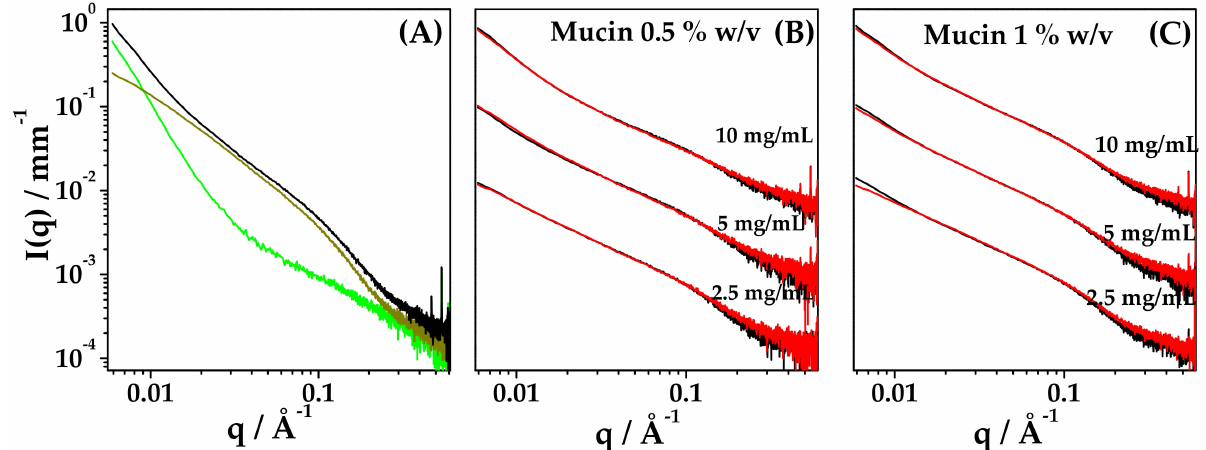
Figure 10. Stability of nanoparticles in mucus model. SAXS intensity profiles. ( A ) 10 mg/mL HYA–DEX nanodispersion (green), 1% w/v mucin (dark yellow) and admixed 10 mg/mL HYA–DEX nanoparticles dispersed in 1% w/v mucin (dark yellow). ( B , C ) Experimental profiles (black) and reconstructed profiles (red) of HYA–DEX nanoparticles dispersed in mucin; mucin concentration ( B ) 0.5% w/v and ( C ) 1% w/v . HYA–DEX concentration: 2.5 mg/mL; 5 mg/mL and 10 mg/mL. In panel ( B , C ), the intensity profiles were rescaled to a better